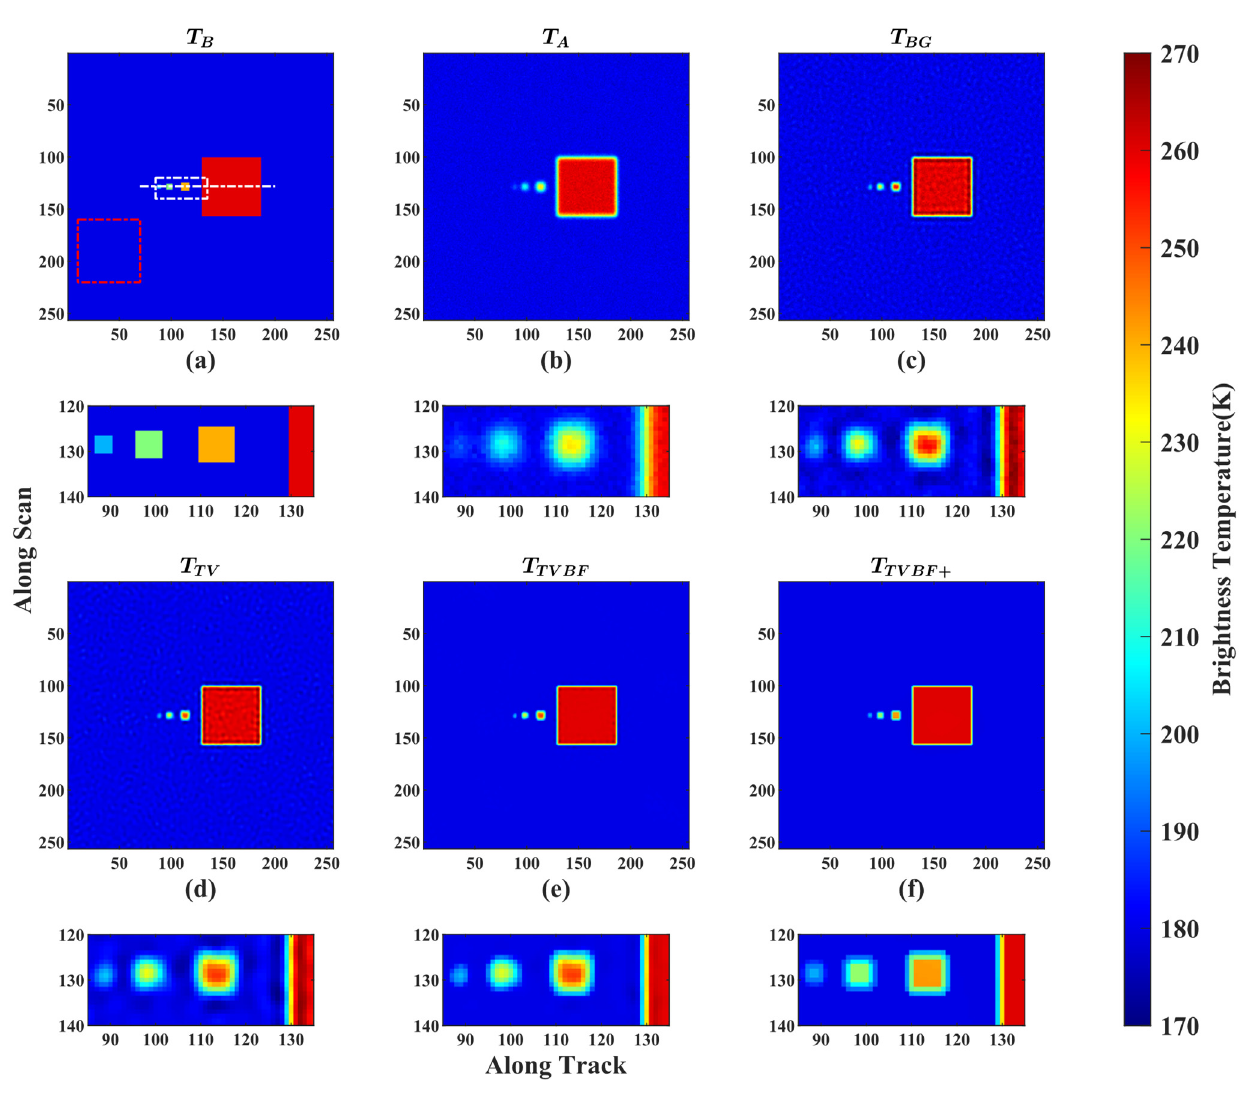
Figure 8. The synthetic scenario and resolution enhancement results. ( a ) Synthetic 18.7 GHz scene temperature; ( b ) simulated 18.7 GHz antenna temperature; ( c ) the Backus–Gilbert enhancement results; ( d ) the TV enhancement results; ( e ) the TVBF enhancement results; ( f ) the TVBF + enhancement results. Table 2. The evaluation indices of the synthetic simulation